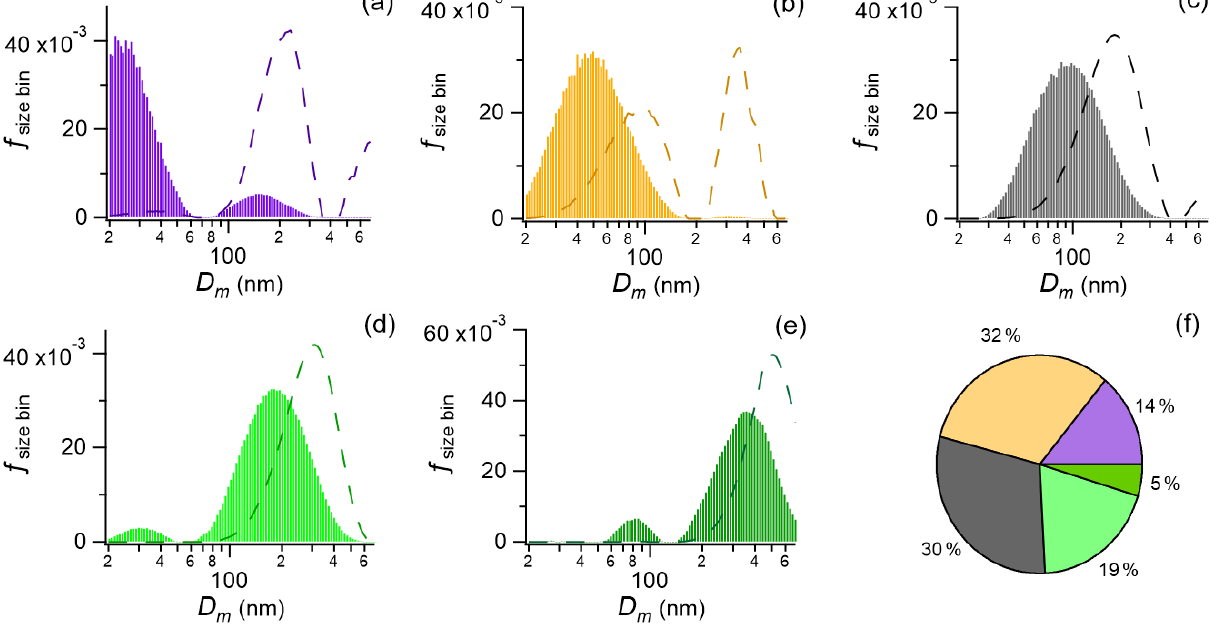
Figure 7. Number (shown as bars) and volume (shown as dashed lines) size distributions of the factors from size PMF analysis and number fractions of total particle number concentrations: (a) traffic-ultrafine particles, (b) cooking-related particles, (c) traffic-fine particles, (d) reg 1 and (e) reg 2. (f) Number fractions of different factors. Traffic-ultrafine denotes the ultrafine particles related to traffic emissions, traffic-fine denotes the fine particles related to traffic emissions and cooking-related denotes the particles related to cooking emissions. Reg 1 and reg 2 denote the particles related to regional sources type 1 and 2,